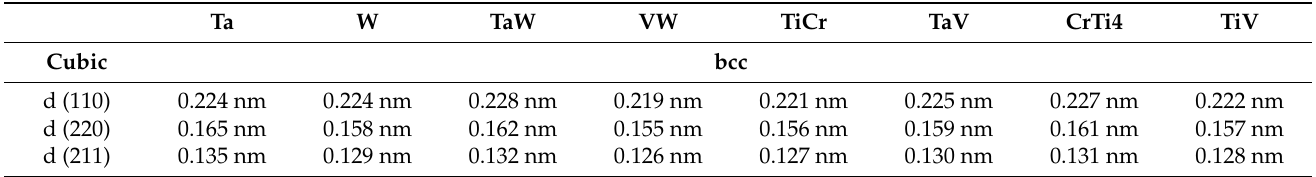
Table 3. Crystal structures and interplanar spacings of several types of elemental and